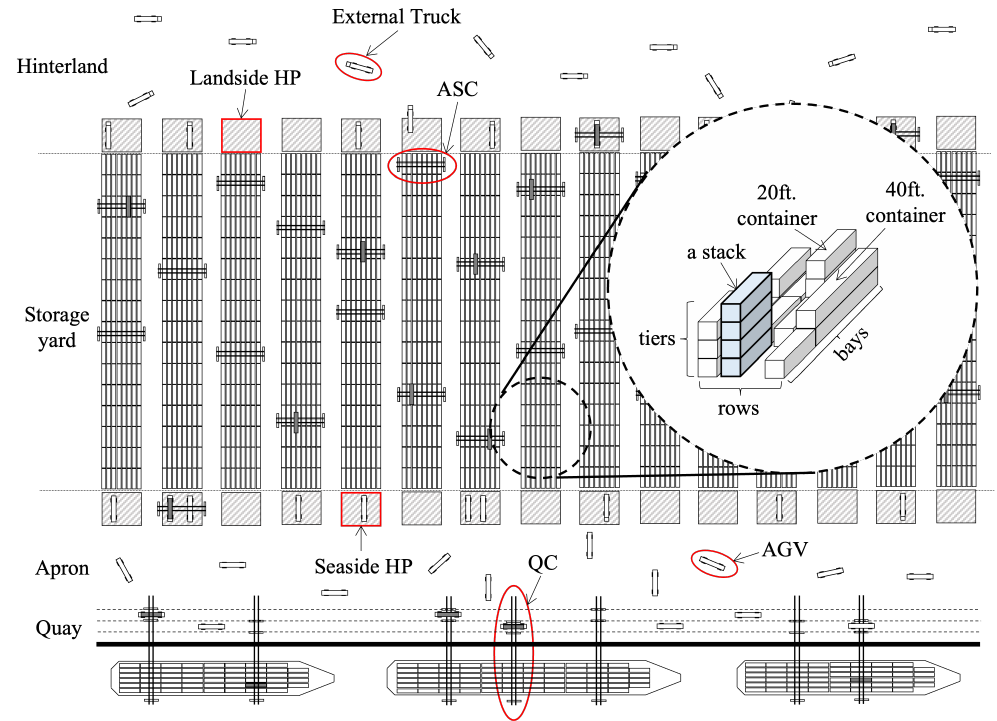
Figure 1. Layout of an automated container